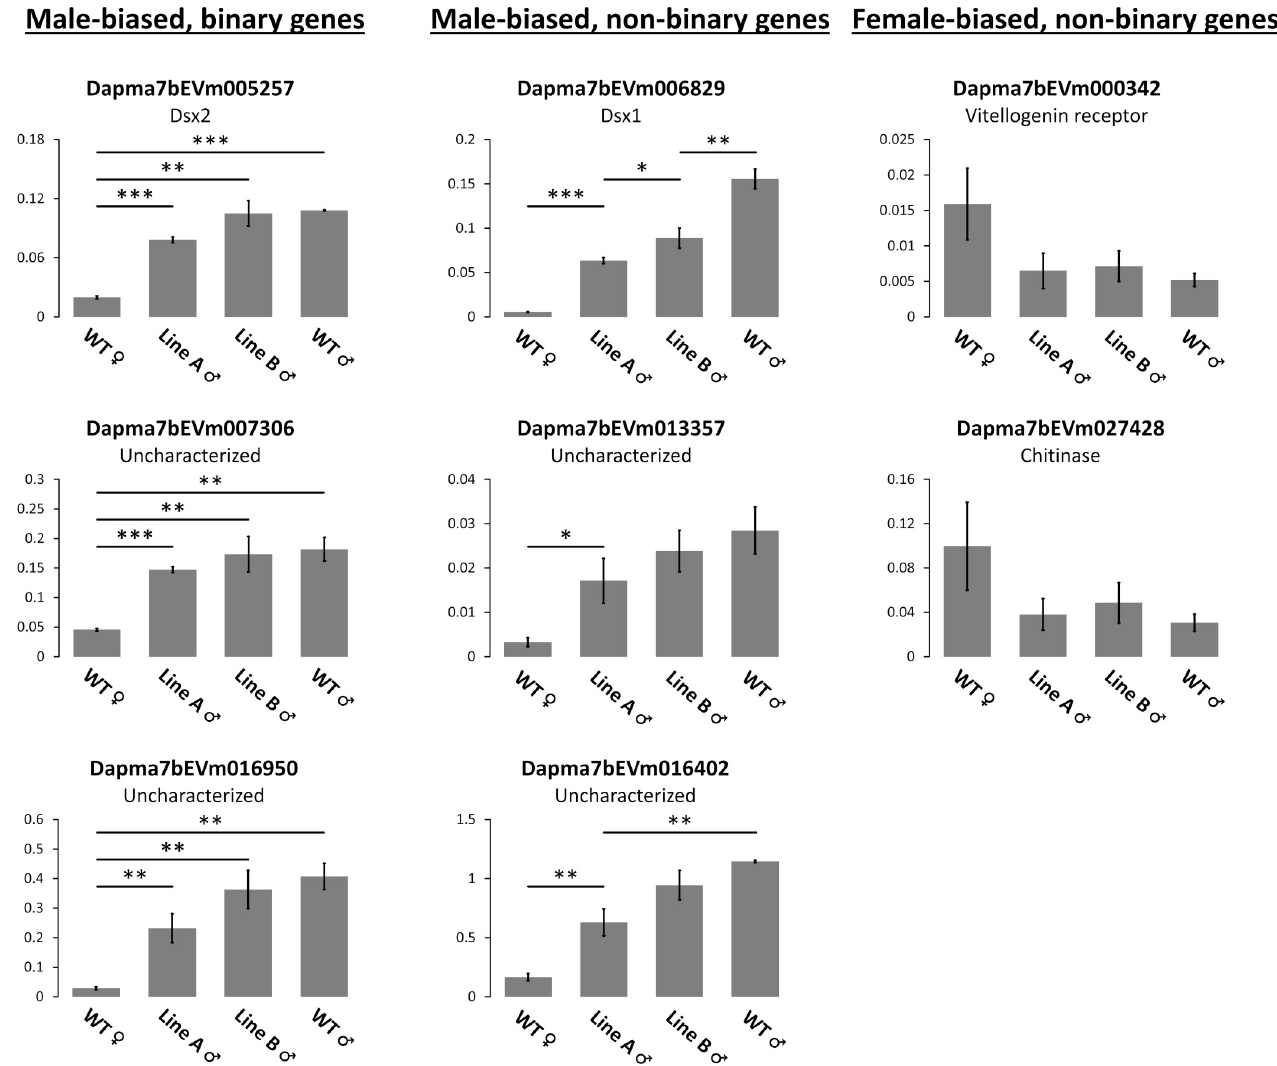
Fig 7. qRT-PCR of selected genes for validating RNA-seq expression. RNA samples of 40h embryos with triplicate for each group were used. All graphs show relative expression by normalization using the housekeeping ribosomal protein L32 gene. Error bars = SEM. � P < 0.05, �� P < 0.01, ��� P < 0.001 (t-test).